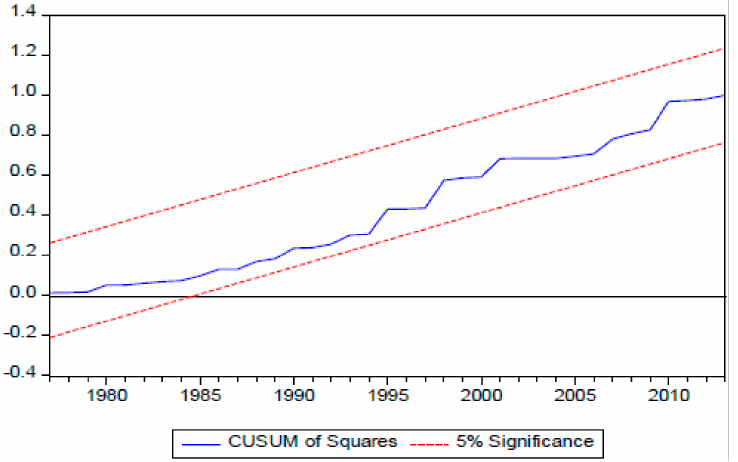
Figure 6. Plot of cumulative sum squares of recursive residuals for Bangladesh.